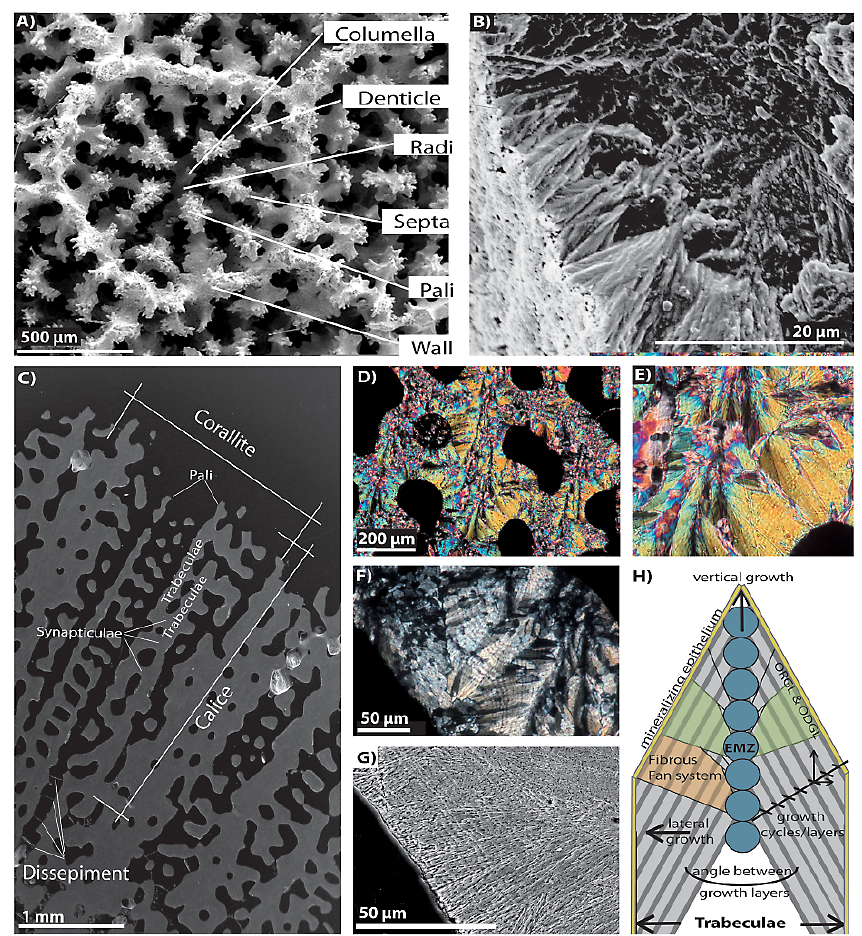
Fig. 1. Micrographs (SEM and PLM) and growth scheme of P. lutea . (A) SEM image of a corallite showing different macro-morphological elements. (B) Broken surface of septa showing the fibrous fan system. (C) Image of a longitudinal cross-section displaying skeletal elements forming the corallite. (D) – (F) Images taken by PLM show the fibrous fan system within the skeleton. Incremental growth layers are visible in the PLM images of the fibrous fan systems ( E weakly visible growth layers in the lower right corner, F after ultrasonic alteration of sample surface). (G) Images of etched skeletal surfaces displaying the incremental nature of growth layers and the continuity of this layers between fibrous fan systems. (H) Schematic representation of coral skeletal growth of a trabeculae (modified after Cuif and Dauphin, 2005a). Stepping growth mode of fibrous fan-systems results in growth layers of organic-rich (ORGL, dark grey) and organic-depleted growth lines (ODGL, light grey) to both sides of the EMZ. The growth layers are oblique and encompass an angel resulting in differences in vertical and lateral extension per growth